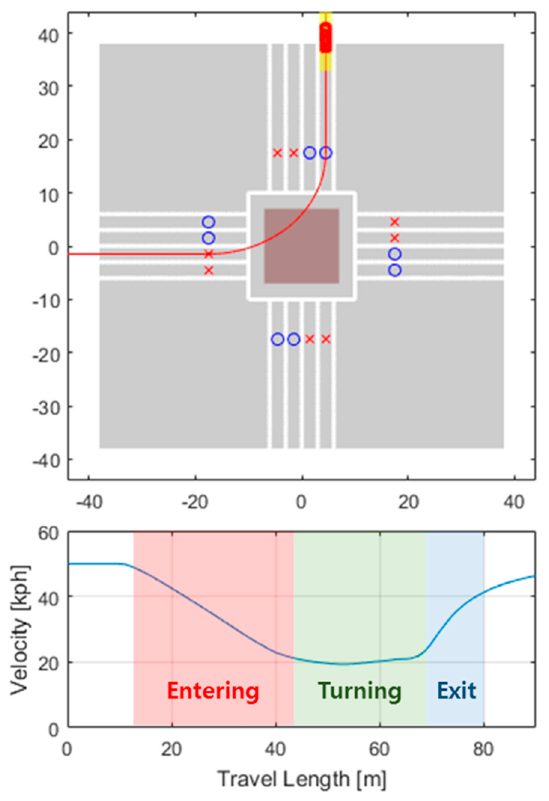
Figure 2. Case example of slowing down driver model before left turn.